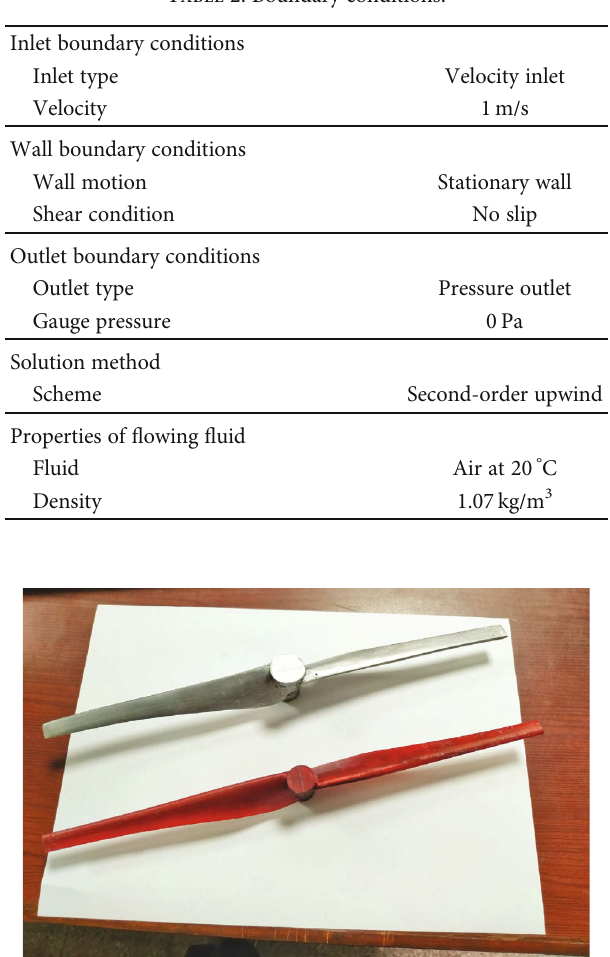
Figure 17: 3D printed and aluminum casted blade together.